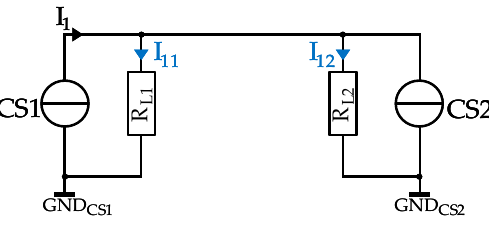
Figure 8. Measurement setup to determine the coupling between the current sources CS1 and CS2.